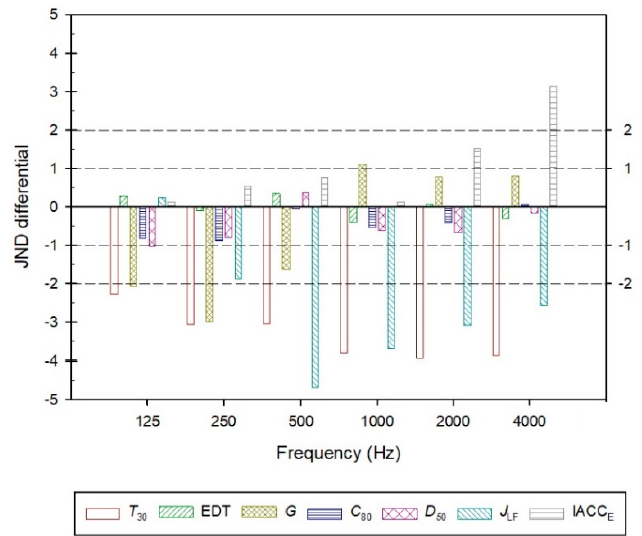
Figure 6. JND differentials spatially averaged versus frequency octave band for the acoustic pa- rameters evaluated: difference between the simulated and measured results divided by JND of the measured value.